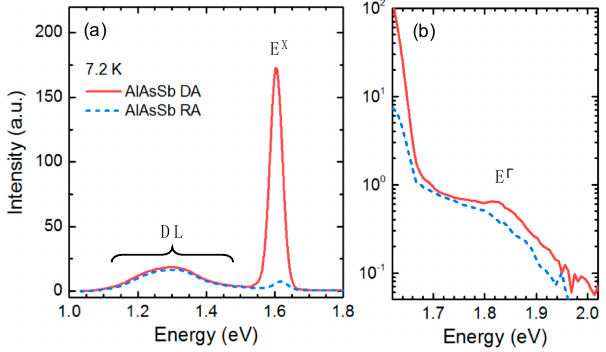
Figure 3. ( a ) Low-temperature PL spectra of the AlAsSb DA and RA samples at 7.2 K; and ( b ) the Γ band transition with a logarithmic scale.